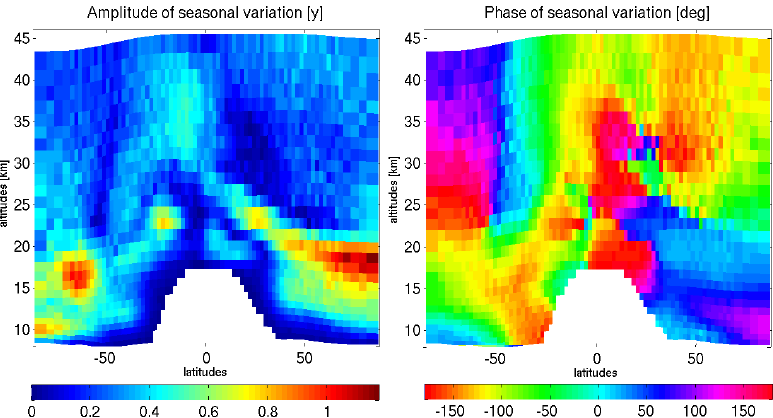
Fig. 9. Altitude-latitude cross-sections of amplitudes (left) and phases (right) of the annual variation derived from least squares method applied on the mean age of air.